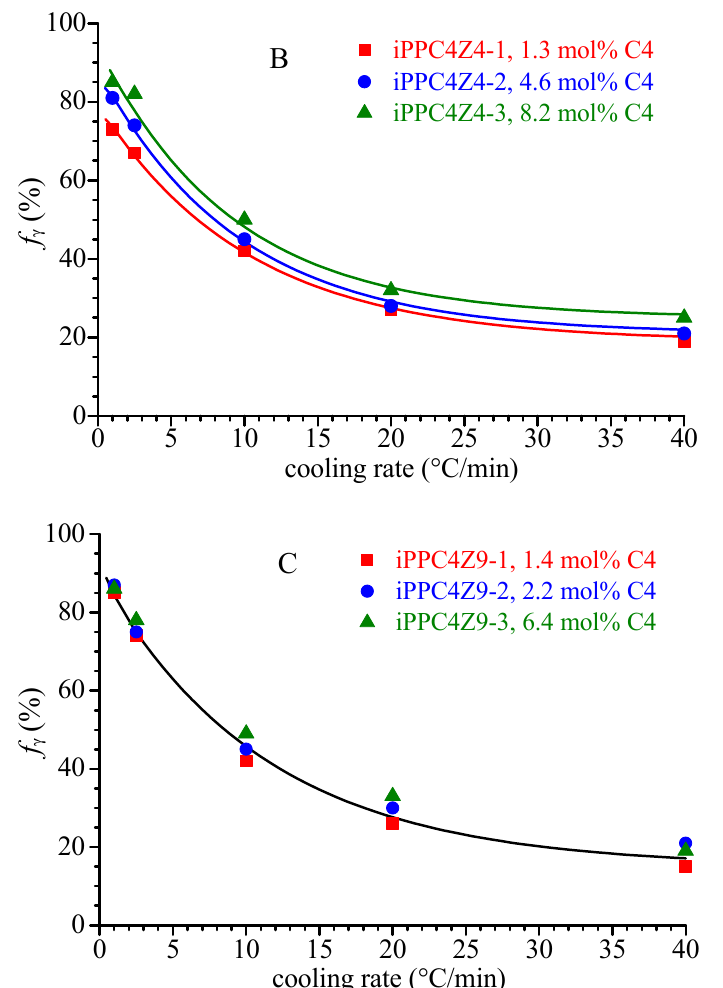
Figure 9. Values of the fraction of γ form that crystallizes in samples of iPPC4 copolymers cooled from the melt at different cooling rates as a function of the cooling rate, evaluated from the diffraction profiles of Figures 6–8. ( A ) Isotactic samples iPPC4Rf-x with [ rr ] < 0.1 mol%, ( B ) samples iPPC4Z4-x with [ rr ] = 2.0–2.4 mol%, and ( C ) samples iPPC4Z9-x with [ rr ] = 2.5–3.4 mol%.